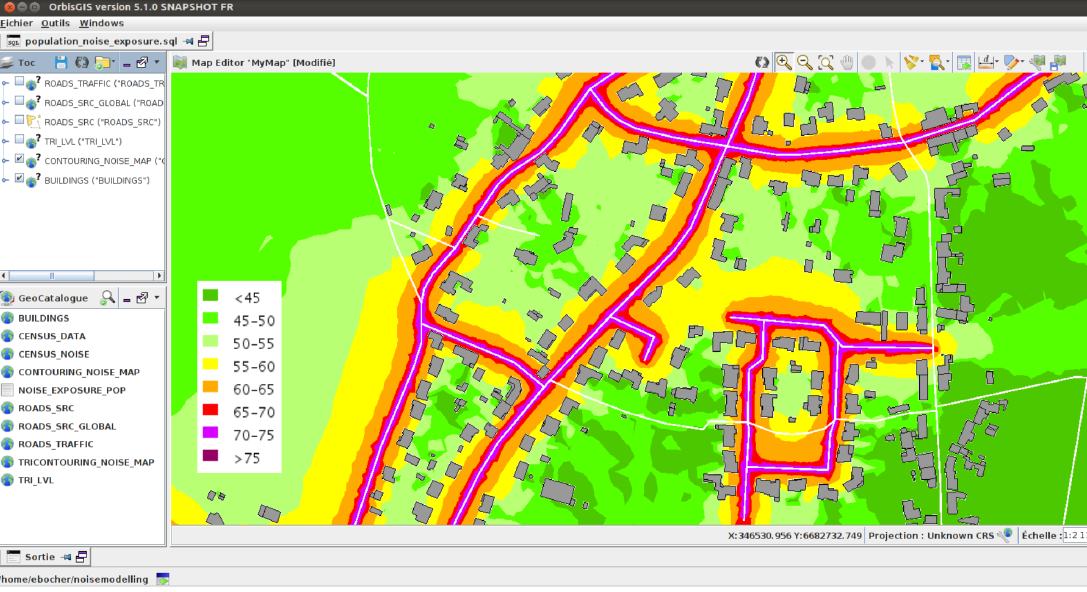
Figure 11. Contour noise